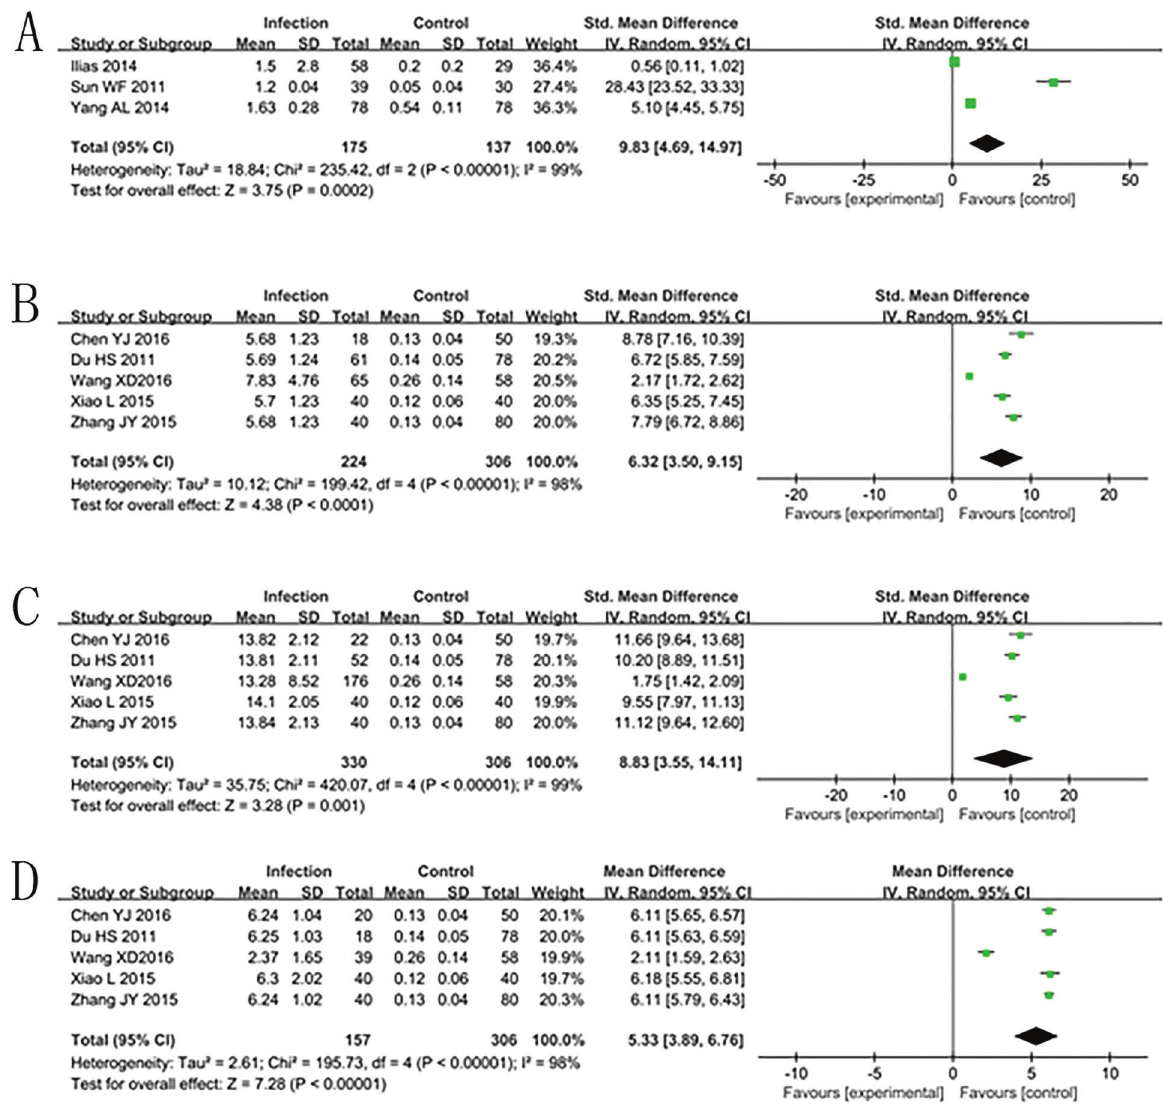
Figure 3. Forest plot for the concentration of procalcitonin (PCT) between A ) bacterial infection and control group, B ) G + bacterial infection and control group, C ) G – bacterial infection and control group, and D ) fungus infection and control